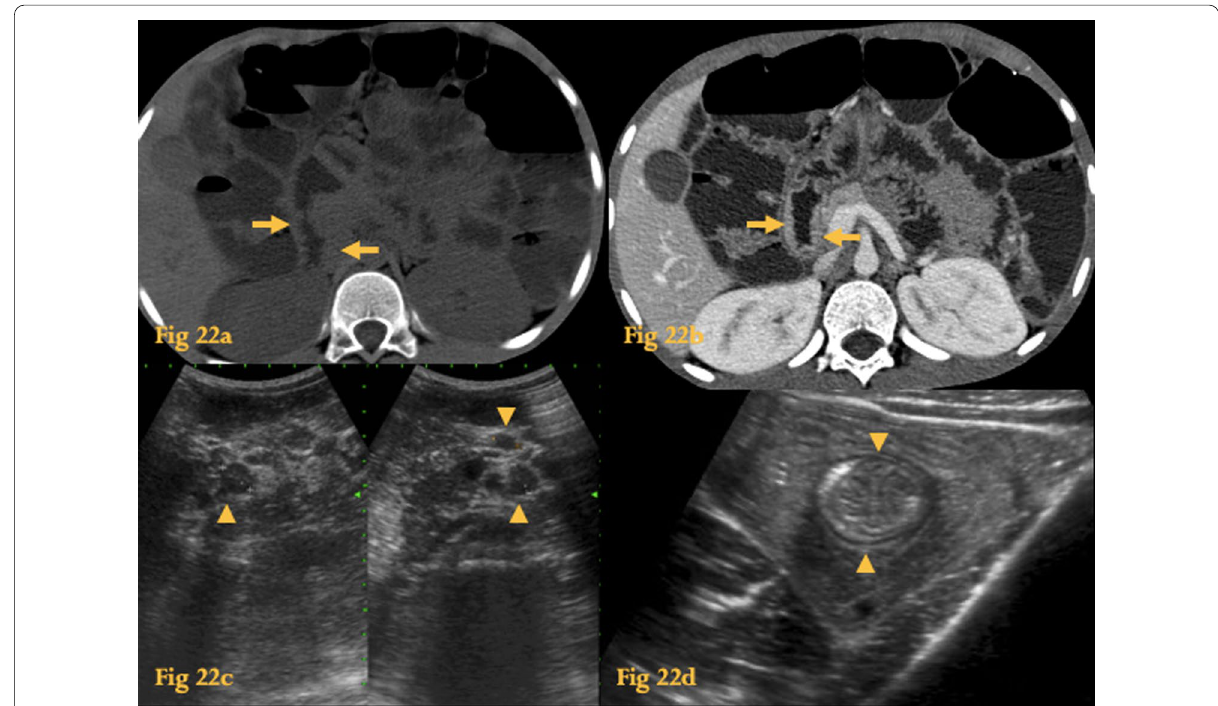
Fig. 22 Celiac disease. Abdominal CT before ( a ) and after iv contrast administration ( b ) of a 14‑year‑old boy shows thickening and irregularity of the duodenal mucosa (arrows), with intense enhancement. Abdominal ultrasound of the same patient ( c ) detected several lymphadenopathies (arrowheads). Duodenal biopsy revealed disappearance of the “villi” associated with crypt hyperplasia, consistent with celiac disease. Abdominal ultrasound of another patient ( d ) who had three incidental transient small bowel intussusceptions (arrowhead), that were not present in a subsequent CT enterography a week later. Duodenal mucosa biopsy showed findings consistent with celiac